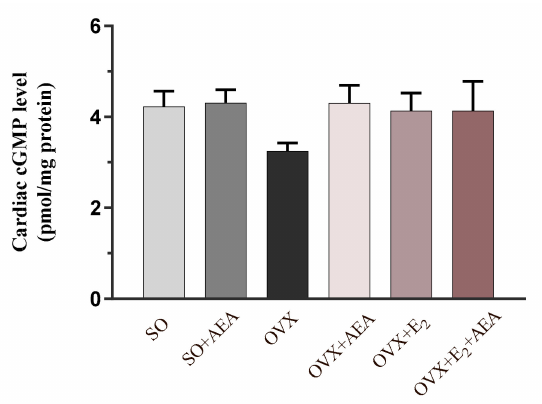
Figure 4. E ff ects of anandamide and estrogen treatment on cardiac cGMP levels in SO and OVX animals (expressed as pmol / mg protein). Results are shown as means ± S.E.M. n = 5–10; cGMP = cyclic guanosine monophosphate.